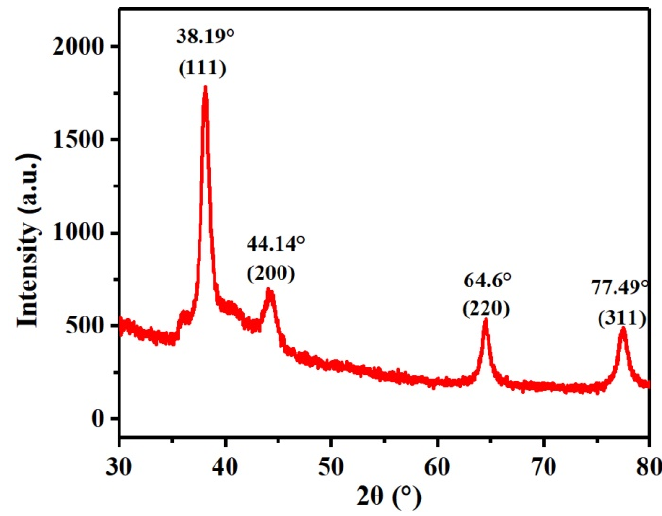
Figure 5. XRD pattern of Ag NPs.